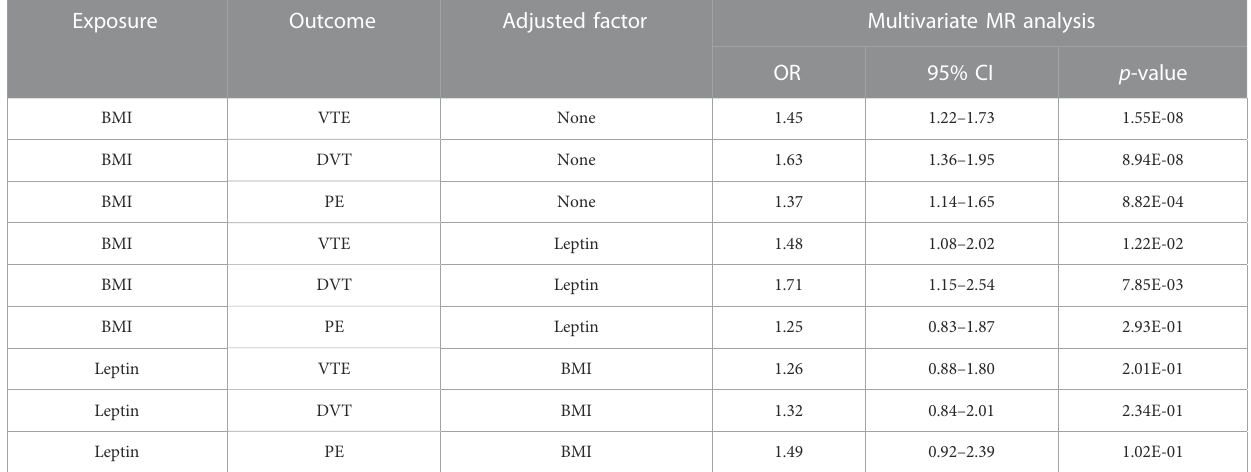
TABLE 5 Multivariate MR